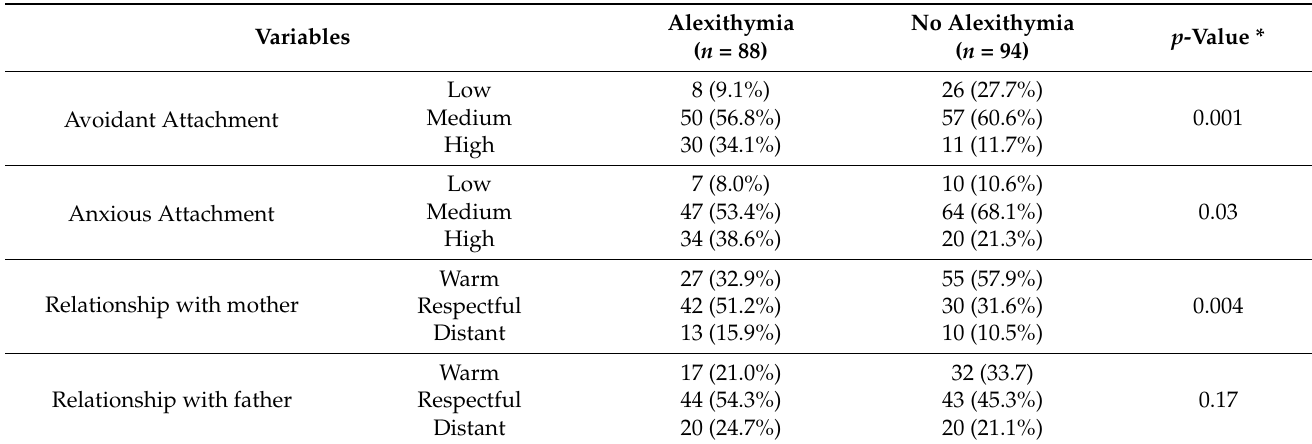
Table 2. Comparison of insecure attachment data (avoidant and anxious) and maternal and paternal relationship for both groups of study (alexithymia and non-alexithymia groups).